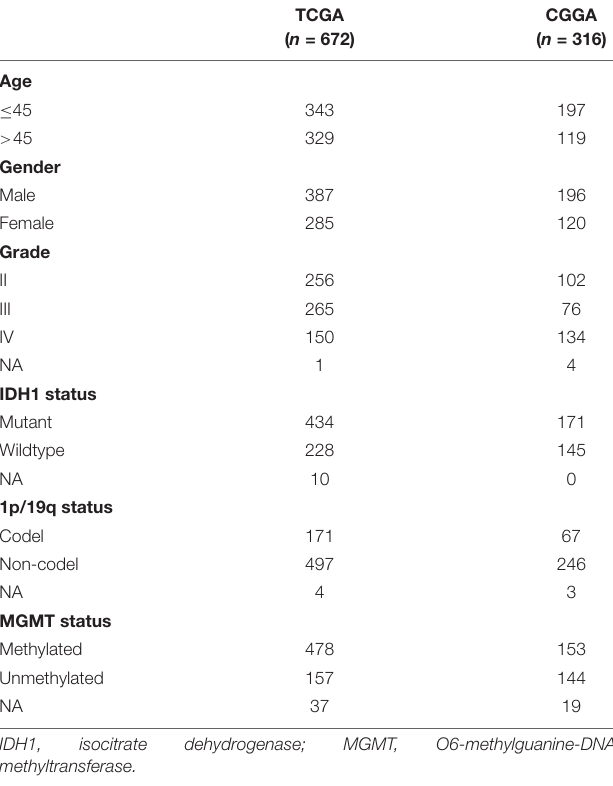
TABLE 1 | Characteristics of TCGA and CGGA datasets.